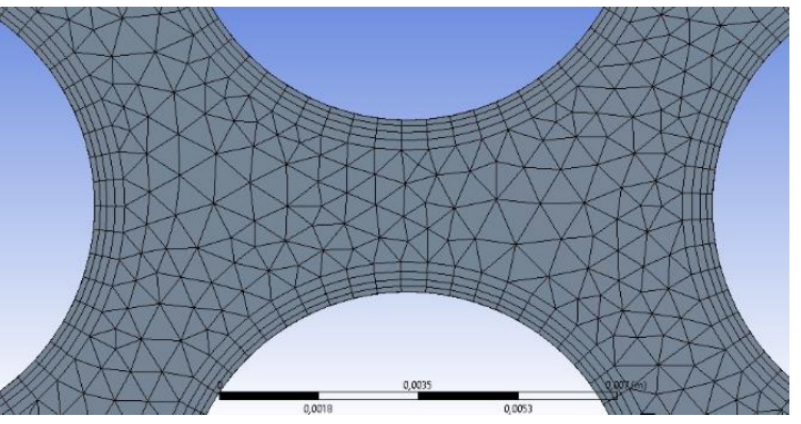
Figure 5. The computational mesh used in the simulations (only x − y plane is shown). The near- wall cells had the smallest dimension of 10 µ m. The total number of elements was 1,139,917. The simulations were performed on a 16-core workstation with an Intel ® Zeon ® 2.2 GHz